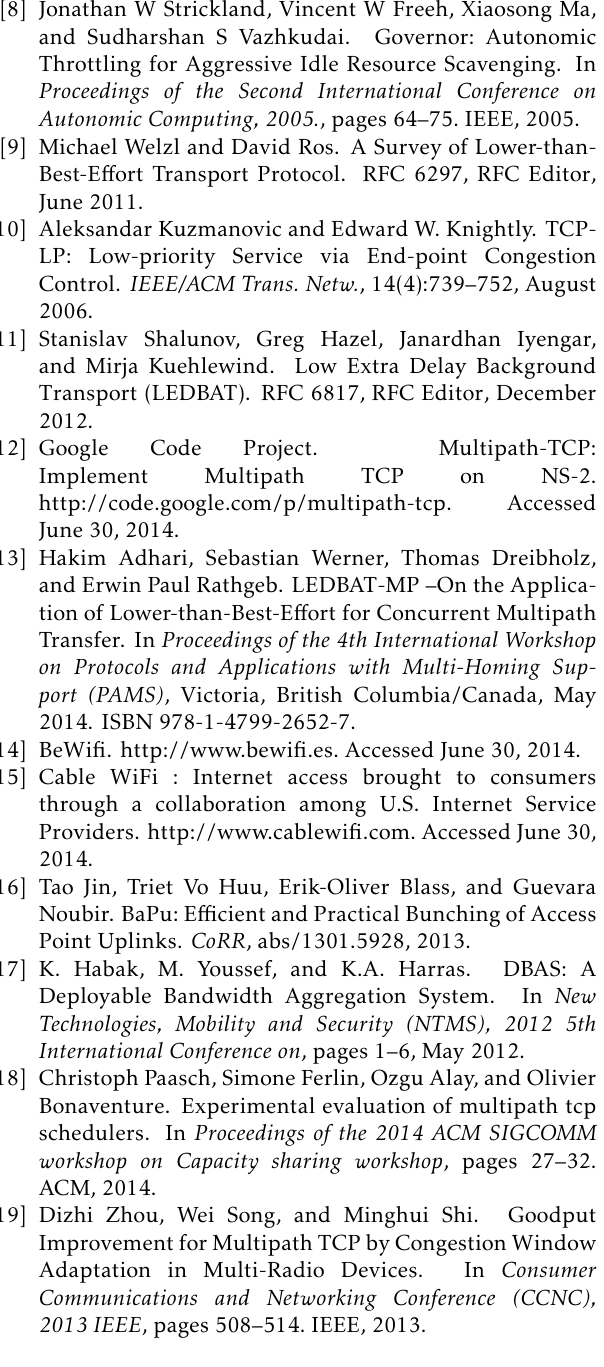
Figure 8. Data Sequence Numbers received at the destination node plotted against time, during the first 4 seconds of the